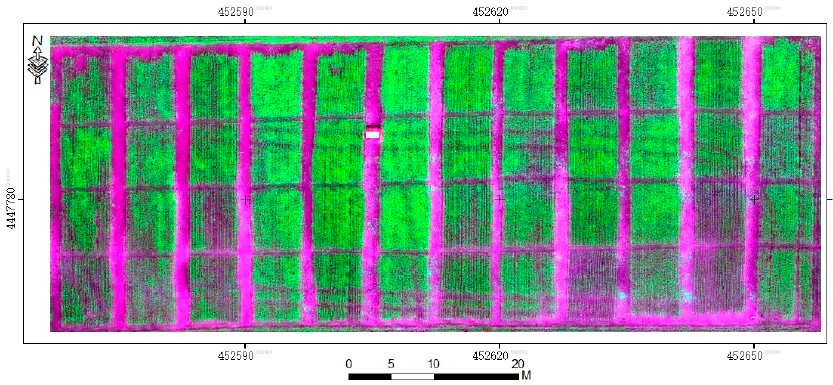
Figure 2. UAV hyper-spectral image for Trail 3.